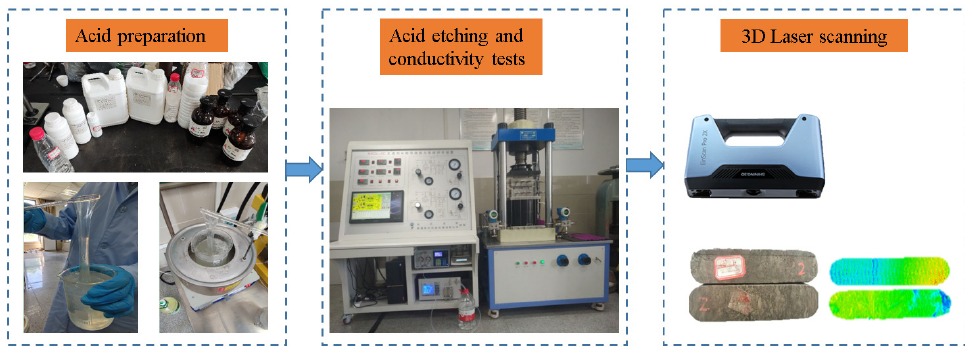
Figure 9. Acid etching conductivity test system.